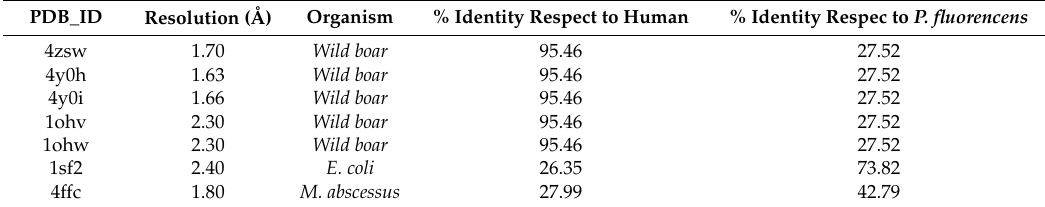
Table 3. GABA aminotransferase crystal structures available in PDB